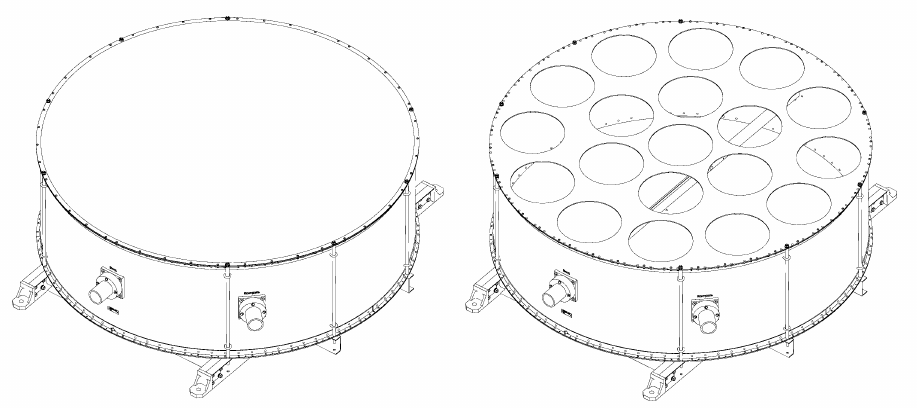
Fig. 1. Flat resonant cavity antenna